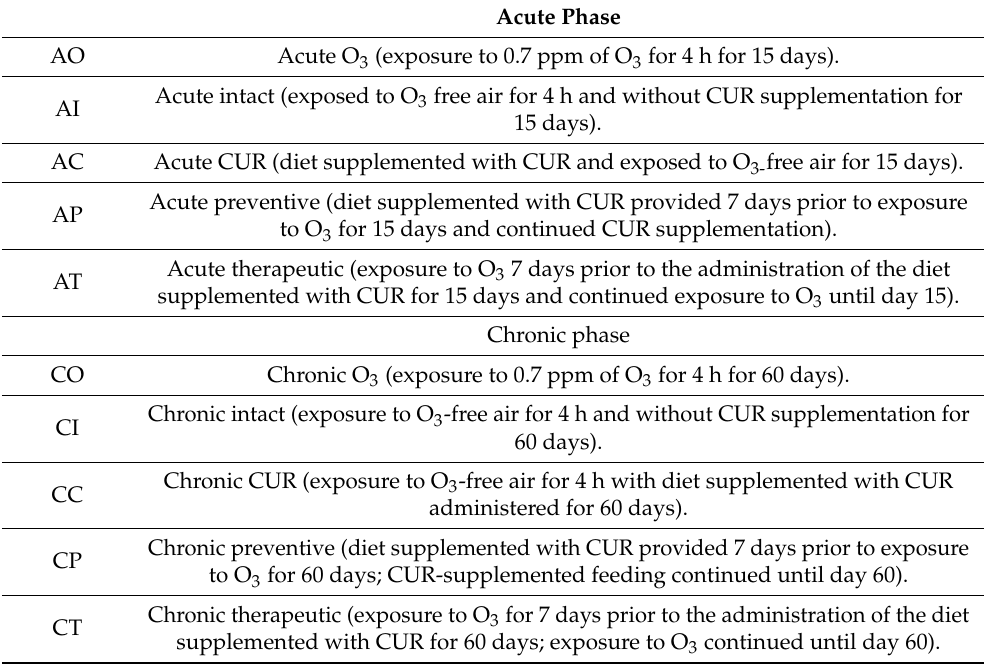
Table 1. Experimental groups and